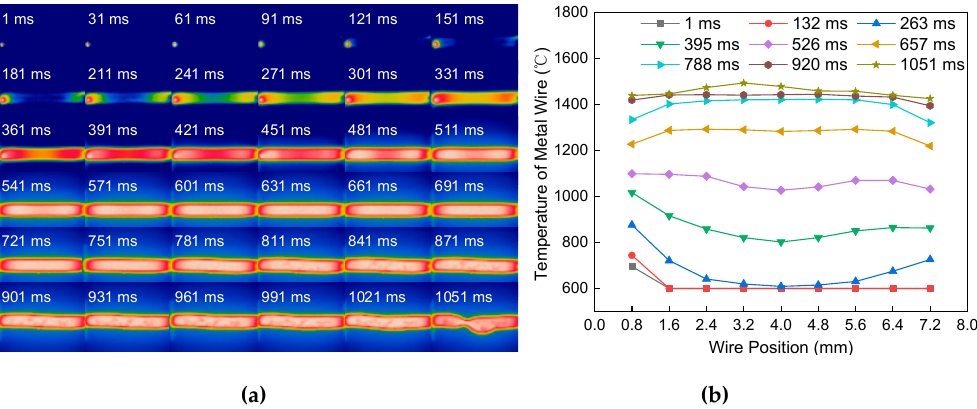
(b). Figure 6. Effect of current on melting of a single metal wire. (a) Melting process. (b) Temperature distribution. Figure 7a shows the melting process of the single metal wire at a constant current of 60 A passing through a length of 8 mm and a diameter of 1.2 mm. It is different from the heat transfer mode in Figure 6a. At the initial stage of heating, the temperature of the metal wire near the end of the electrode begins to rise. In the middle of heating, the heat accumulated and transmitted from both ends of the electrode to the middle of the wire. The temperature of the wire tends to balance